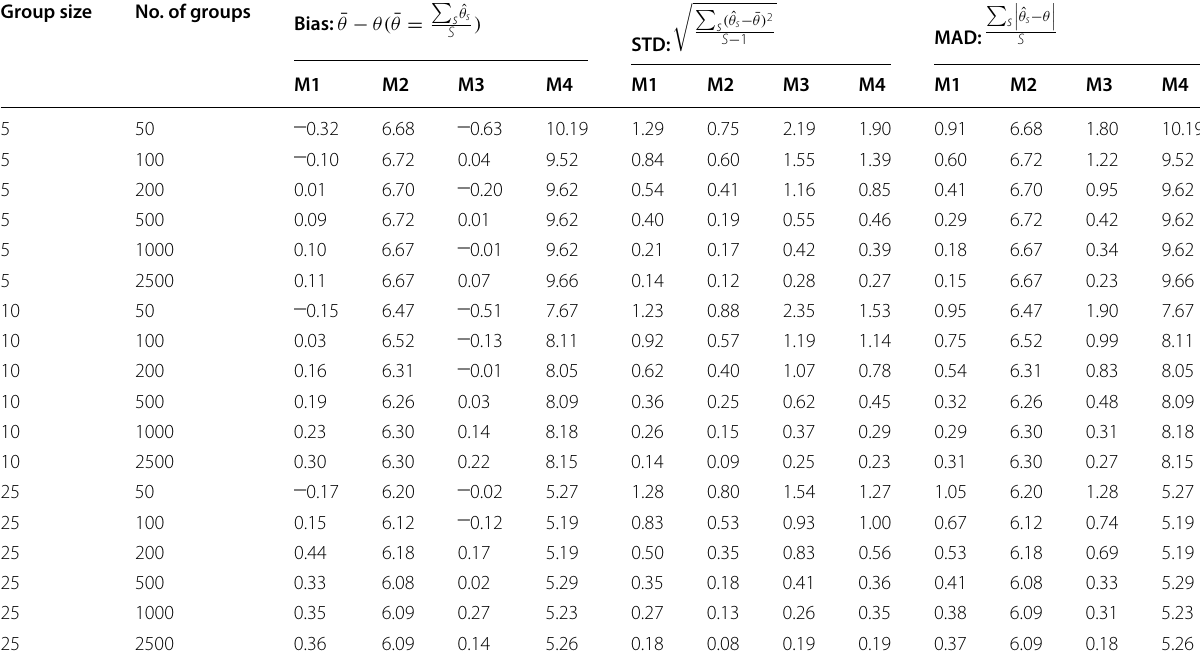
Table 3 Bias, standard deviation and mean absolute deviation of the estimates for the endogenous effects coefficient ( J ) of the logit endogenous social interactions